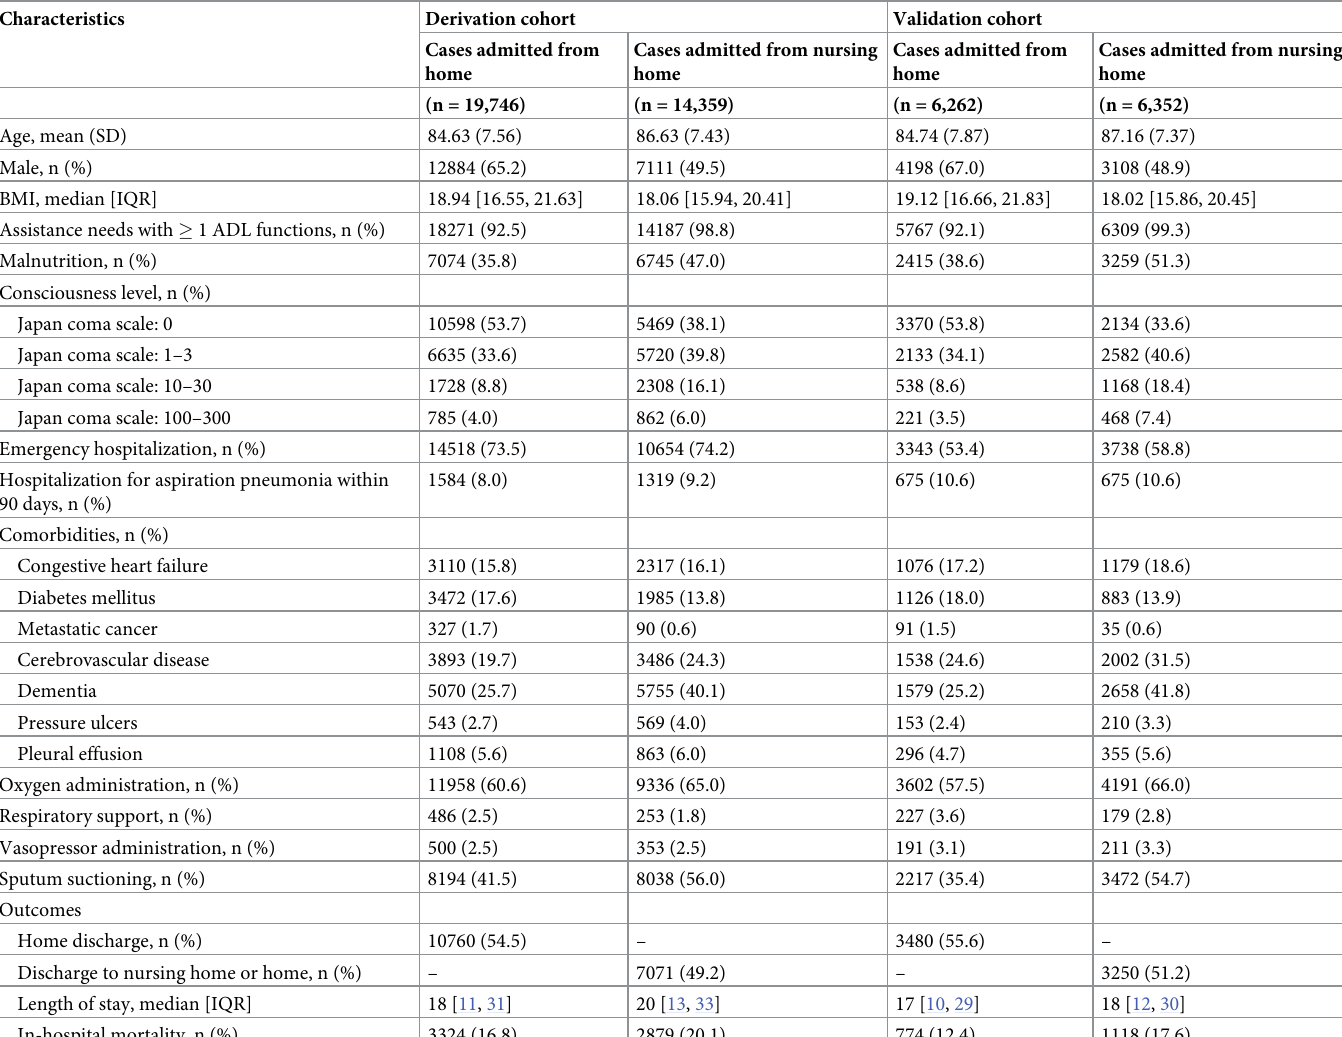
Table 1. Baseline characteristics and outcomes of the derivation and validation cohorts.